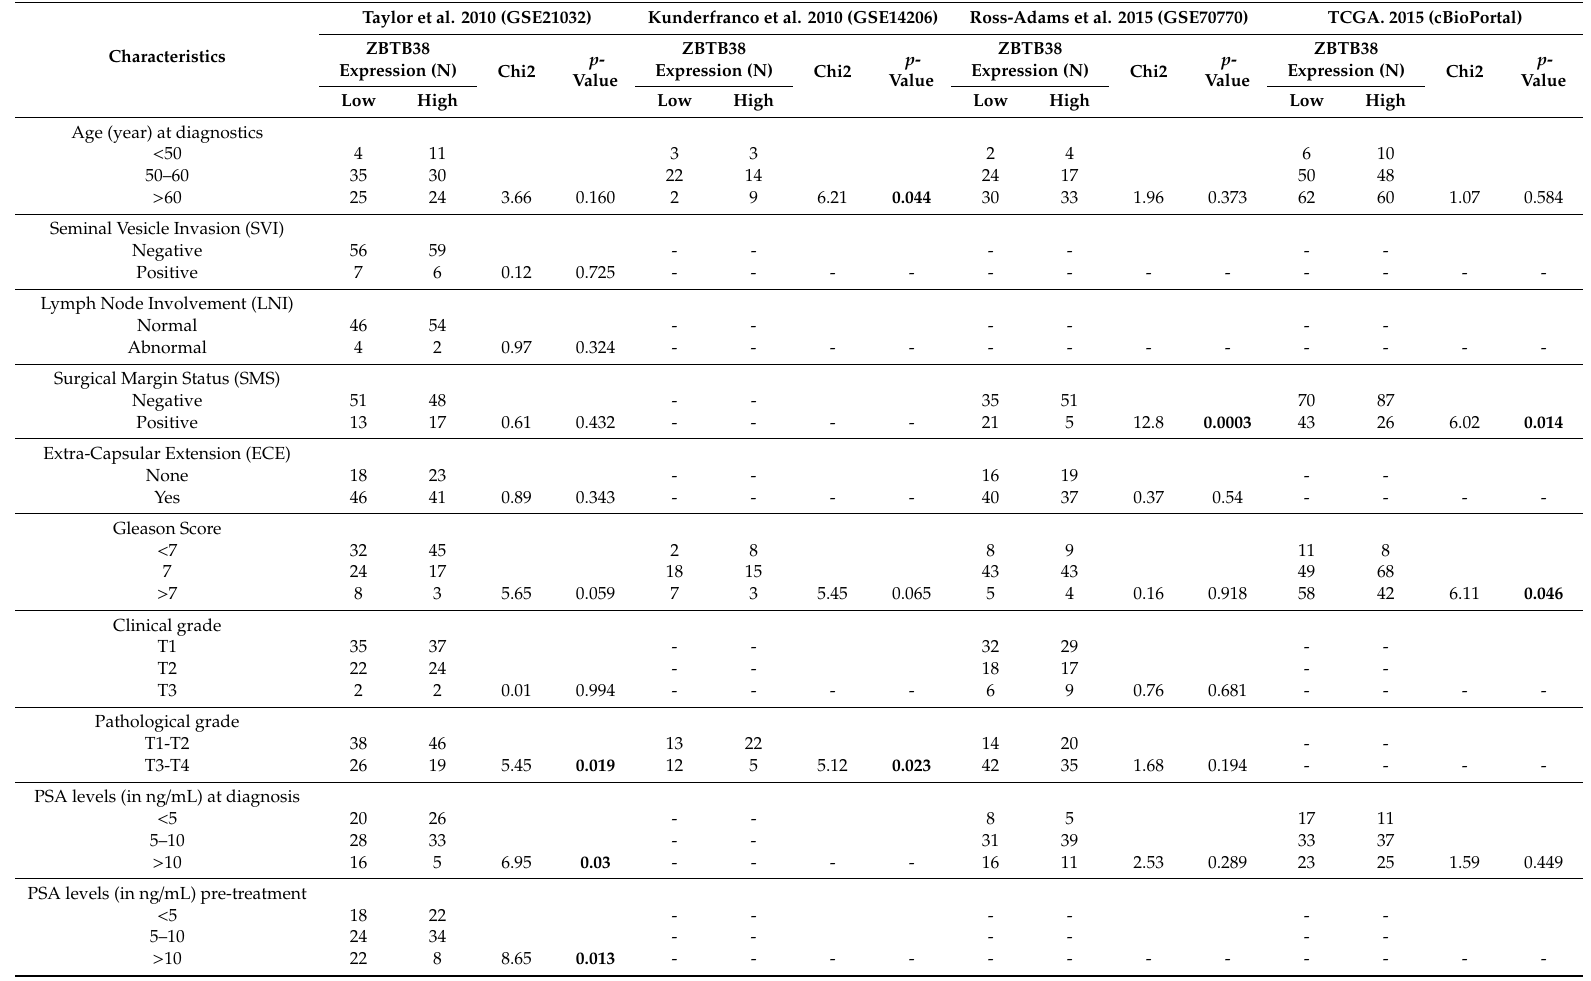
Table 2. Clinical significance of ZBTB38 expression in localised prostate